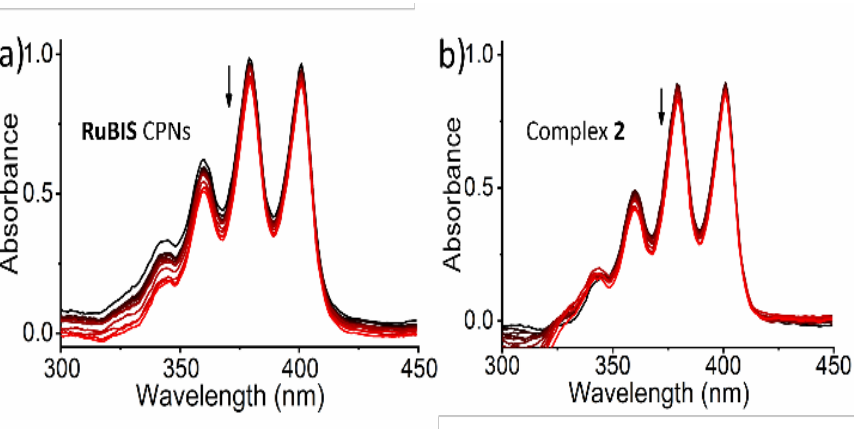
Figure 7. The negligible absorption spectral changes of ABMDMA upon green light irradiation in the presence of ( a ) RuBIS CPNs (25 μg/mL), ( b ) complex 2 (19 μg/mL). The 1 O 2 generation is studied in Opti-MEM medium. The arrows indicate the evolution of the spectra with time.